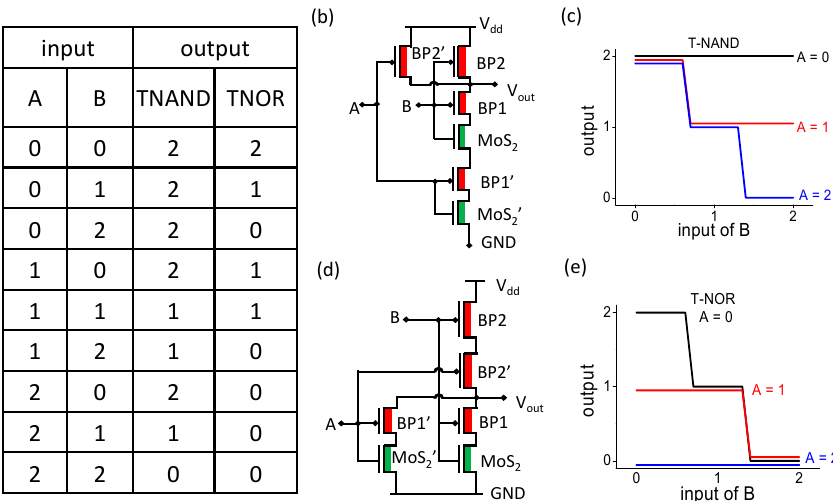
Figure 3. ( a ) The truth table of 2-input ternary NOT-AND (NAND) and NOT-OR (NOR) gates. The designed circuits ( b ) and V out -V in characteristic curves ( c ) of the T-NAND gate. The designed circuits ( d ) and V out -V in characteristic curves ( e ) of the T-NOR gate.